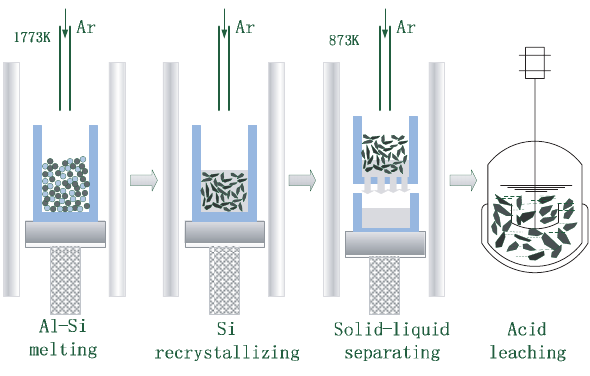
Fig. 1: Segregation coefficients of Boron and phosphorus within Al-Si and Si system [1, 12–14,